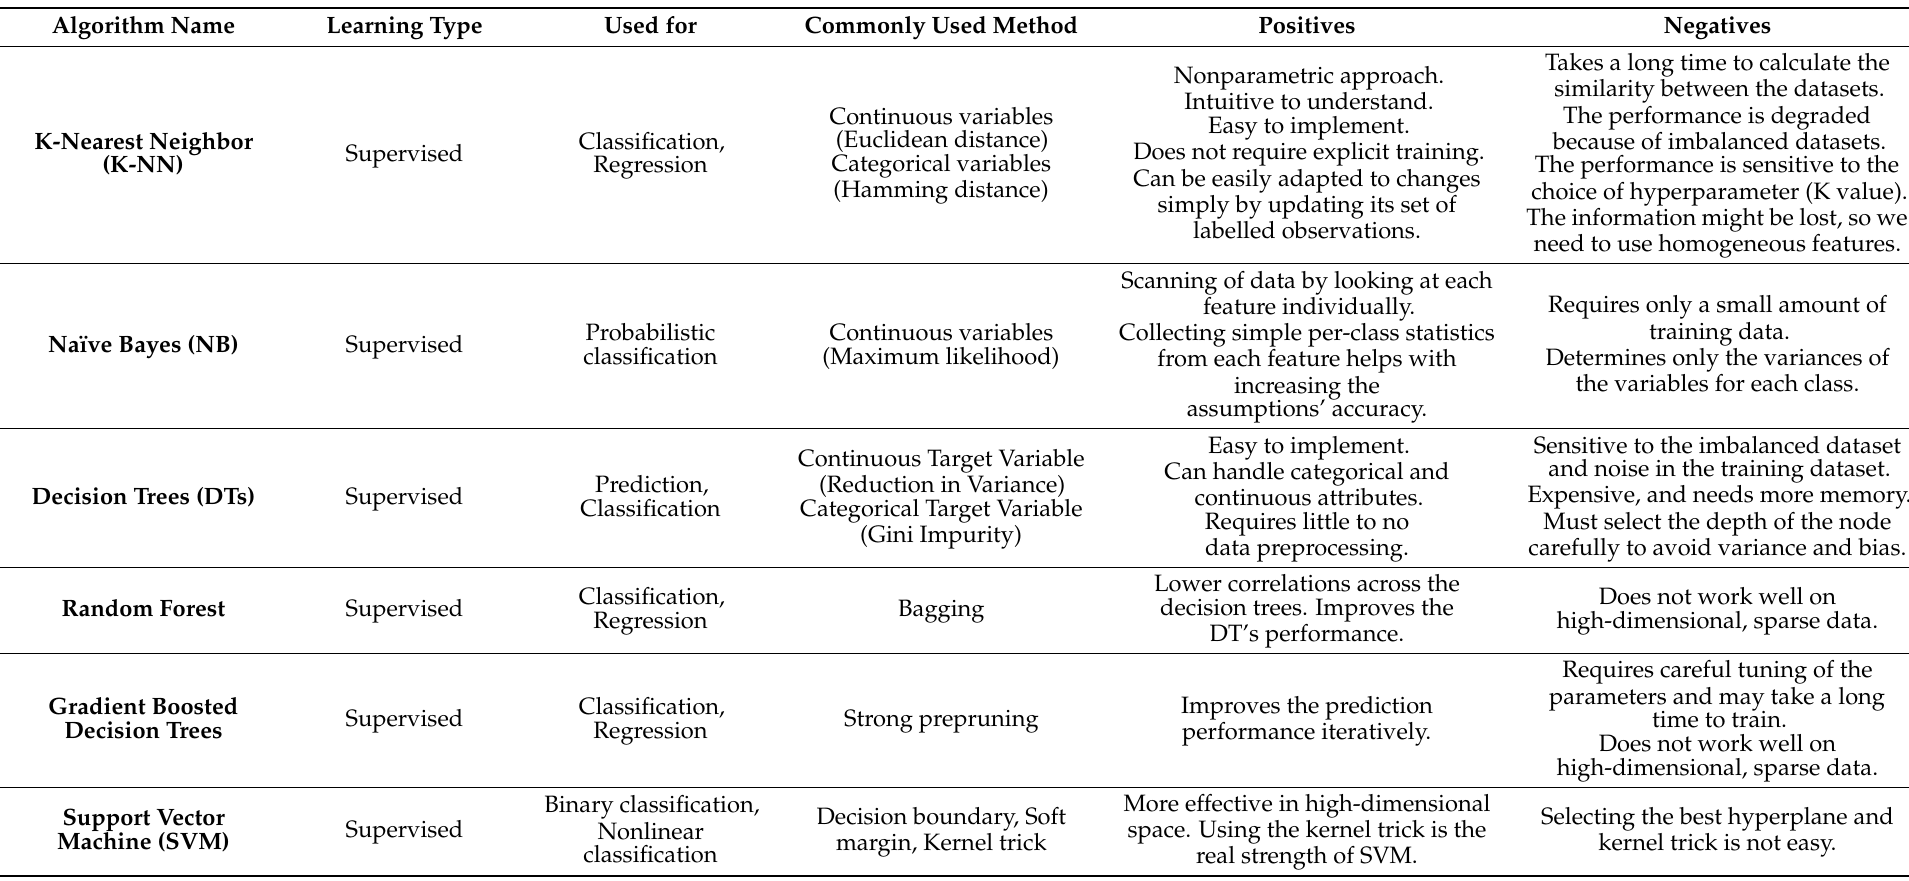
Table 3. Summary of the reviewed ML